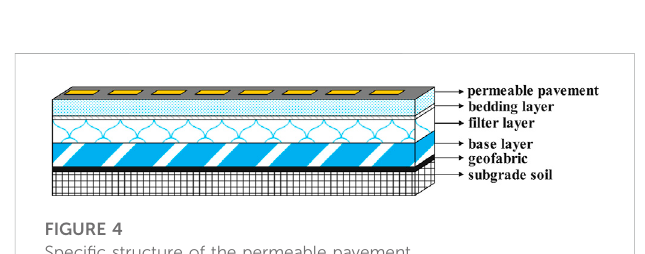
FIGURE 4 Speci fi c structure of the permeable